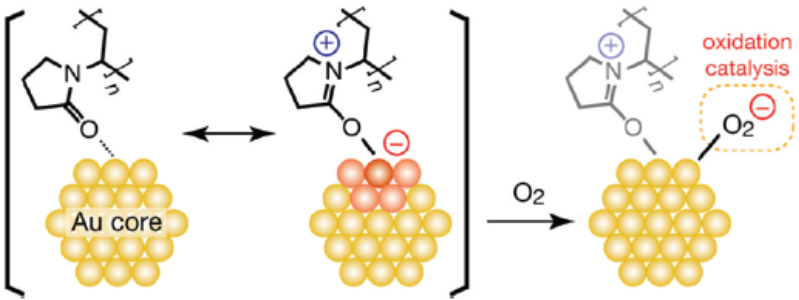
Figure 11. Mechanism for the activation of molecular oxygen by Au cluster